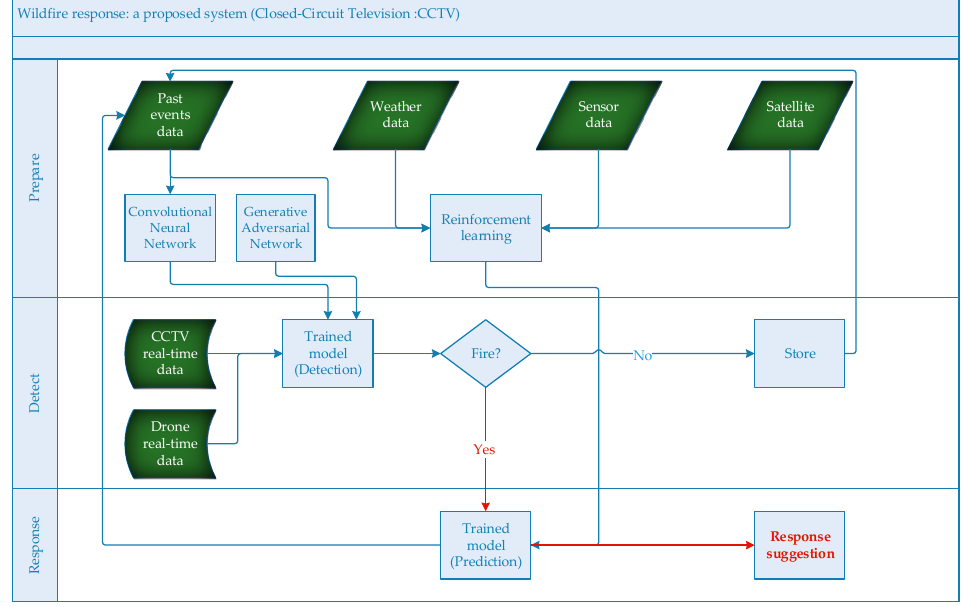
Figure 5. Wildfire response: the proposed system diagram.